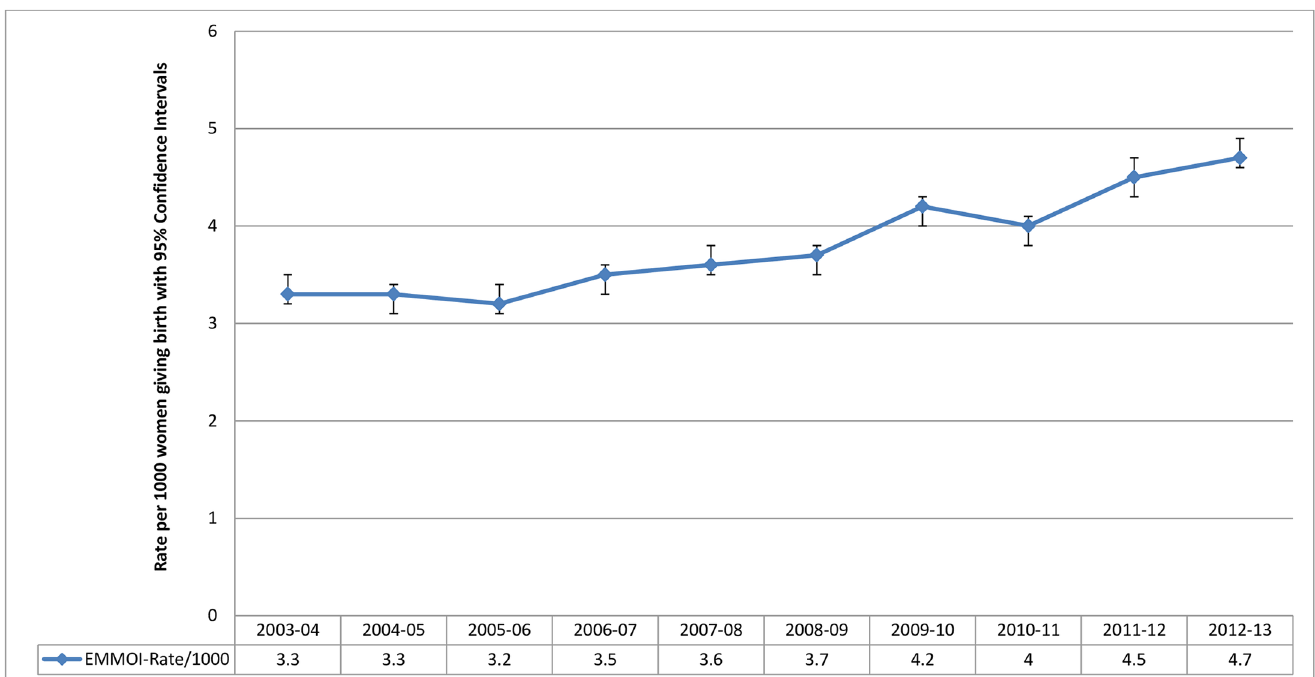
Fig 3. Trends in maternal morbidity outcomes during childbirth in England from 2003 – 04 to 2012 – 13 using the EMMOI; Hospital Episode Statistics data England.